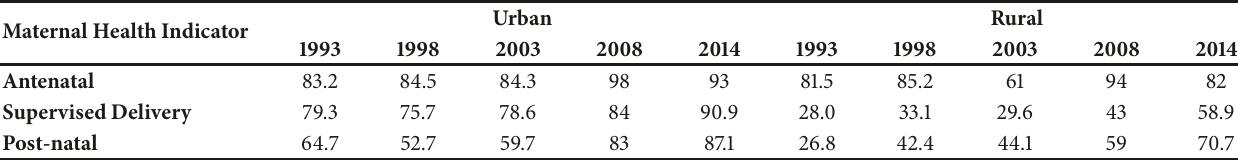
Figure 1: MMR trends in Ghana, 1990-2015. Source: Millennium Development Goals Report [5]. Table 1: Trends in maternal health indicators by residence in Ghana